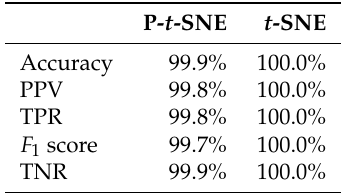
Table 4. Accuracy, PPV, TPR, F 1 score, and TNR of the application of P- t -SNE and t -SNE damage detection and classification method presented in Sections 3 and 4: scenario 1 and the sum of the inverse distances